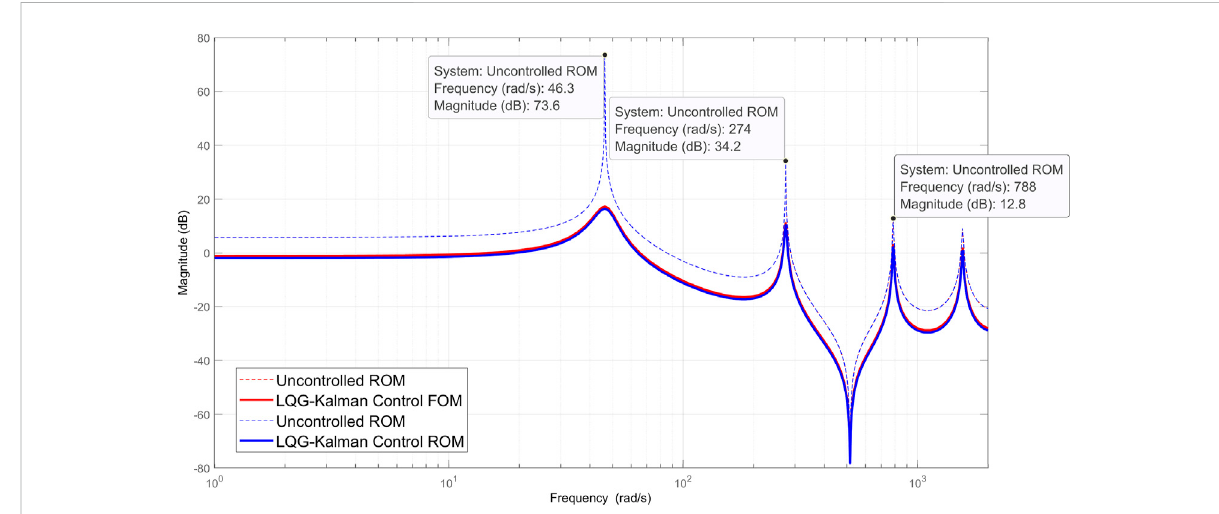
Frequencies of the three fi rst modes in full and reduced models using the LQR control w th 112 dofs of 10 distributed sensors.